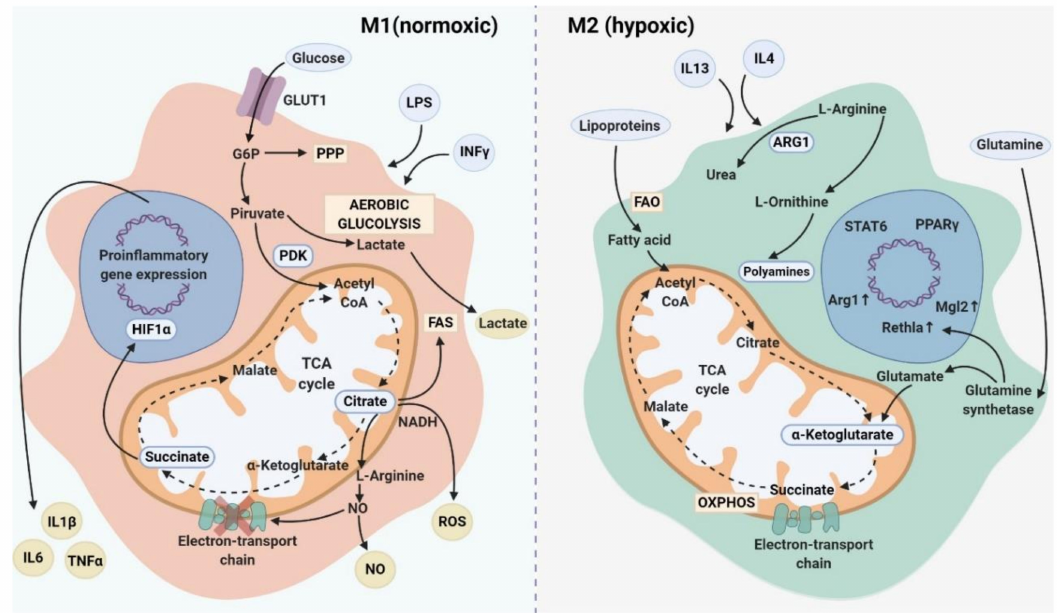
Figure 2. Metabolic characteristics of M1 and M2 macrophages. ARG1—Arginase